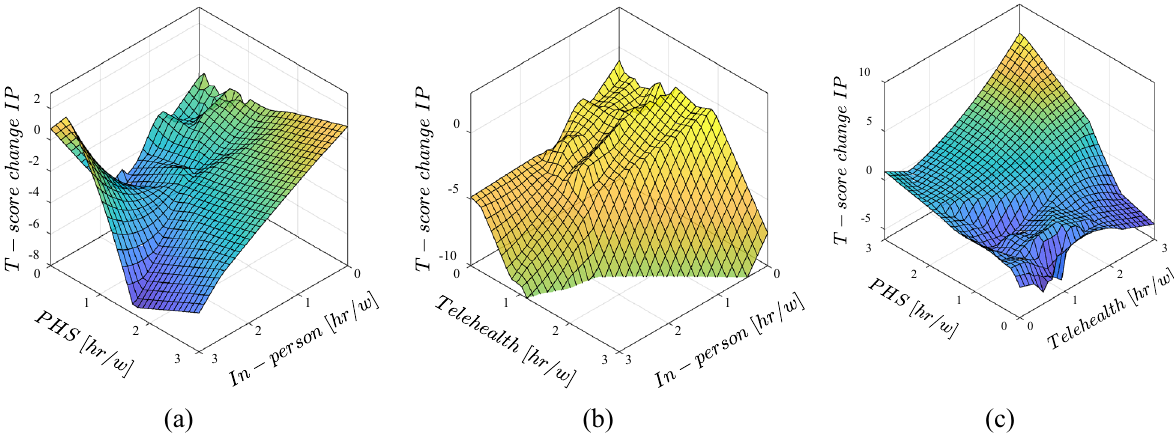
Figure 5. Effects of different speech therapy approaches on the change in internalizing problems in comparison data from pre- and post-lockdown, ( a ) effect of concurrent in-person and PHS treatments, ( b ) effect of concurrent telehealth and in-person treatments, ( c ) effect of concurrent PHS and telehealth treatments.